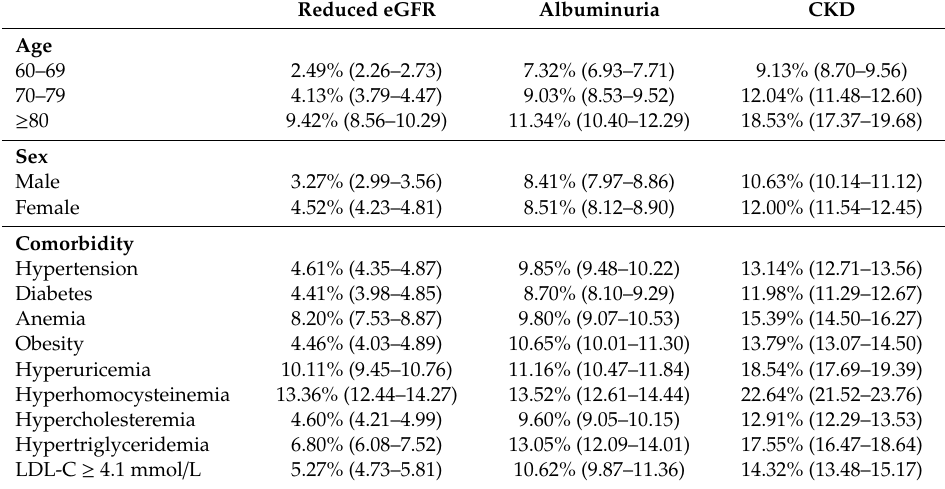
Table 3. Prevalence of indicators of kidney function, by age, sex, and comorbidity.